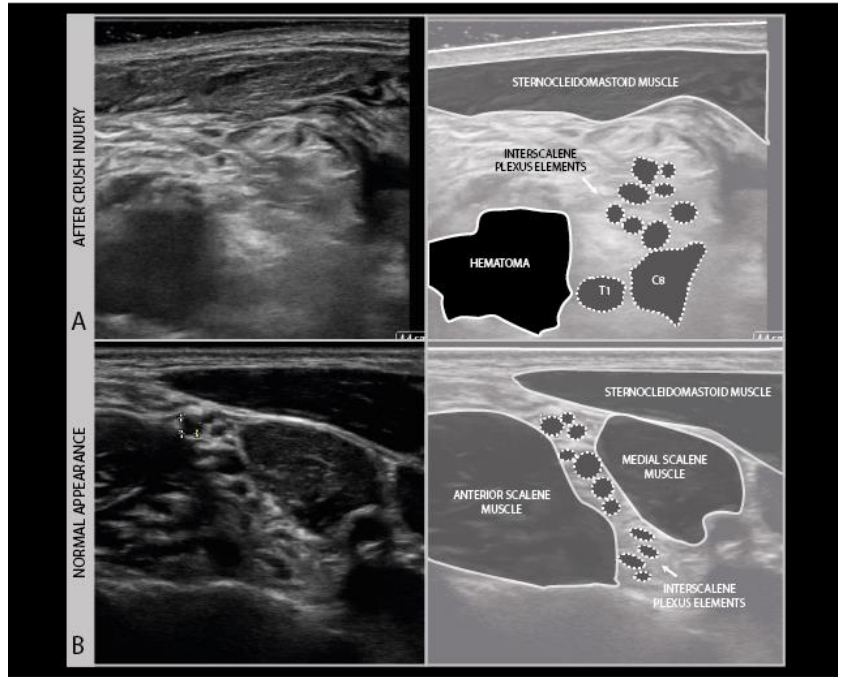
Figure 12. Right brachial plexus trauma with costoclavicular crush injury on day 1: hematoma with swollen C6–C7–C8–T1 elements ( A ) and normal interscalene plexus ( B ) for comparison.